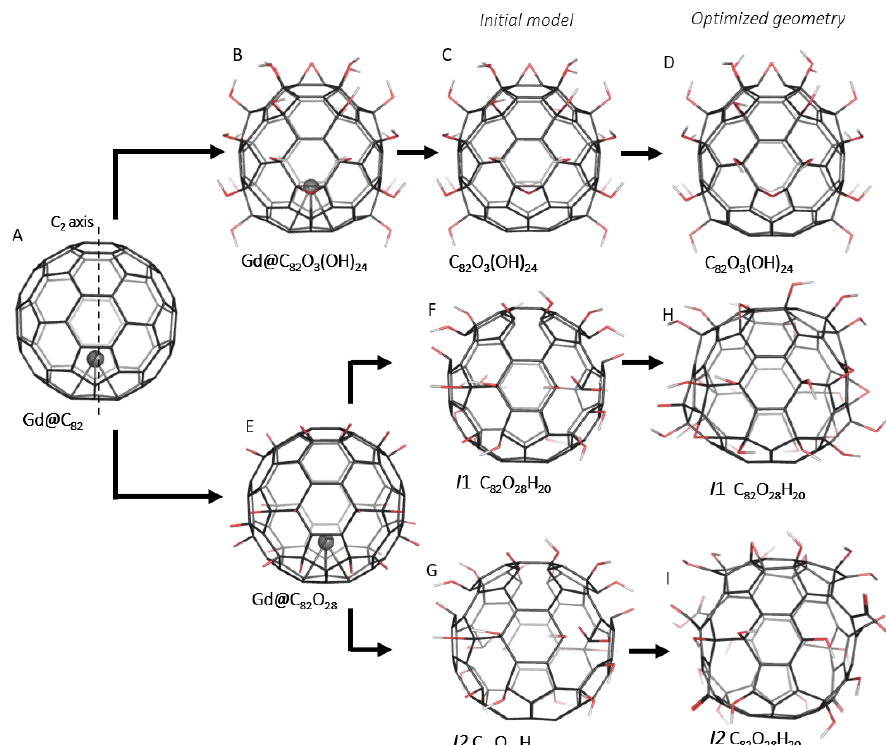
Figure 2. Some structural models of possible C 82 O x H y complexes. ( A ) Gd@C 82 ; ( B ) Gd@C 82 O 3 (OH) 24 . ( C , F , G ) Initial structural models of C 82 O 3 (OH) 24 , where I 1 is C 82 O 8 (OH) 20 and I 2 is C 82 O 6 (OOH) 2 (OH) 18 , valent isomers of the C 82 O 28 H 20 complex, respectively. ( D , H , I ) Equilibrium geometries of C 82 O 3 (OH) 24 , I 1 and I 2 isomers of the C 82 O 28 H 20 complex, respectively (atomic coordinates of I 1 and I 2 isomers can be found in the Supplementary Materials Section). Carbon, gadolinium, oxygen and hydrogen atoms are depicted in black, gray, red and white, respectively.